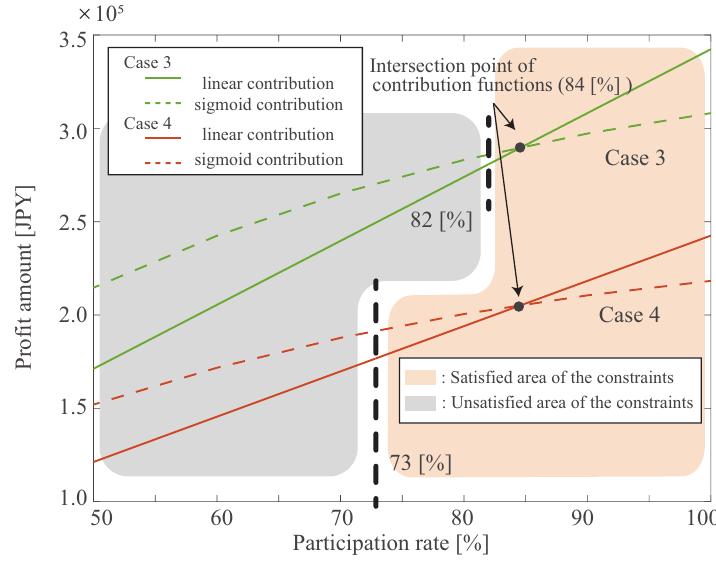
Figure 15. Profit comparison for the case study (Case 3 and 4) with the participation rate of customers.